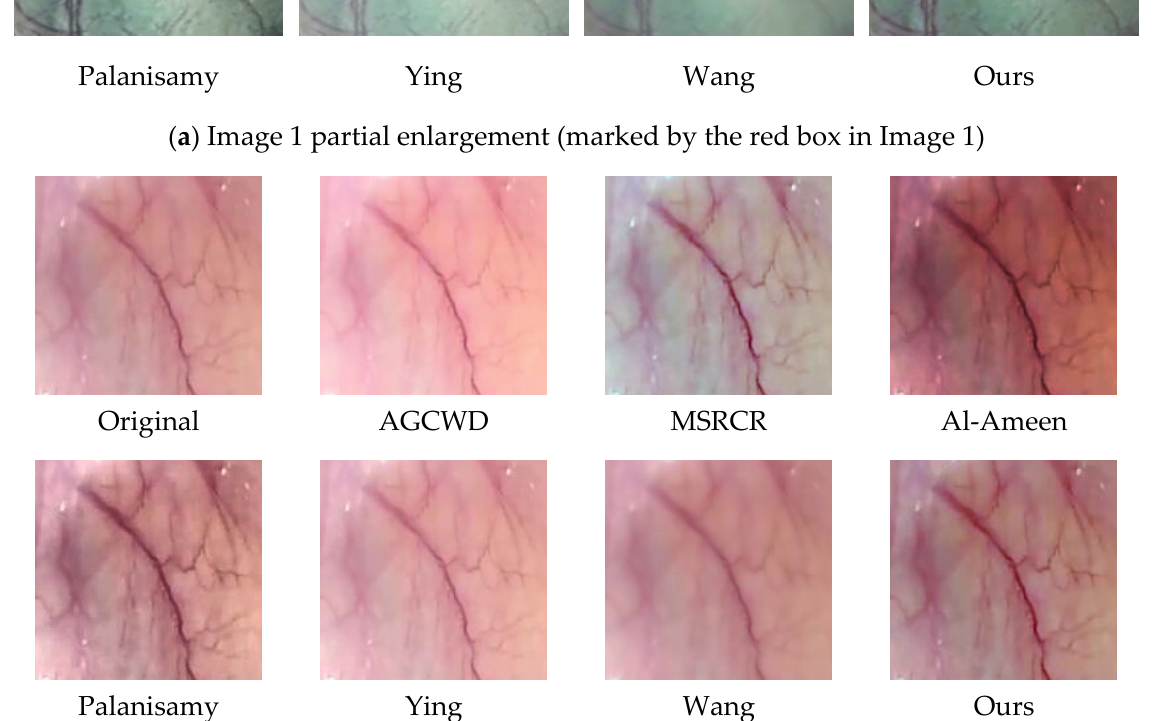
Figure 11. partial enlargement. ( a ) shows a magnified view of the enhanced high bright spot region in image 1, ( b ) shows a magnified view of the enhanced tissue vascular region in image 2.